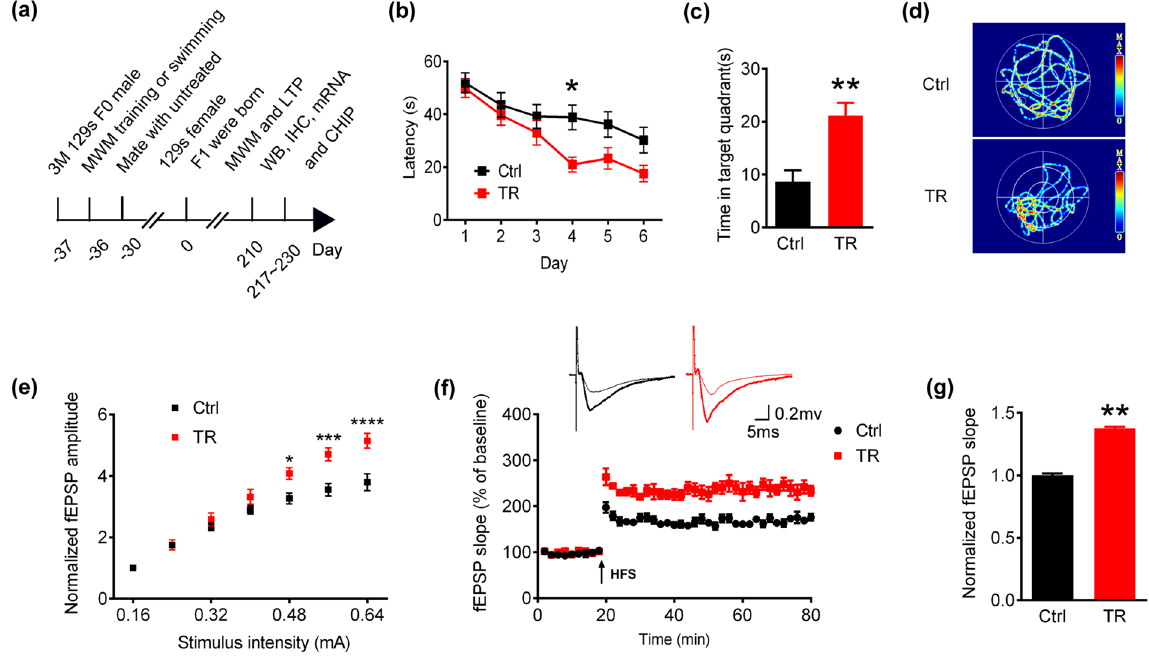
Figure 1. Paternal spatial training improves cognitive performance and synaptic transmission in 129s F1 offspring. ( a ) Spatial training paradigm and the experimental procedures. The birth of F1 offspring was defined as day zero. 37 days ago, F0 males were collected and engaged to Morris water maze (MWM) training or swimming (control). Those who behaved well were selected to mate with untreated females after MWM. The F1 offspring from different cages were bred under the same maintenance. When offspring grew up to 7-m old, they were conducted with MWM, Electrophysiological analysis (LTP), Western blotting (WB), Immunohistochemistry (IHC), mRNA extraction, and Chromatin immunoprecipitation (ChIP). ( b ) Escape latency to find the hidden platform in Morris water maze during 6 days training (two-way ANOVA row factor, F 5,229 = 10.72, p < 0.0001; Bonferroni post hoc tests, * p < 0.05, n = 8 per group). ( c ) Quantitative analysis of time spent in the target quadrants measured at day 8 after removed the platform. Bar graphs show mean ± SEM ( ** p < 0.01, two-tail t-test, n = 6~8 per group). ( d ) The swimming pathway in the maze recorded at day 8 after removed the platform. ( e ) The Input/Output curve of the fEPSP recorded at cornu ammonis 1 (CA1) pyramidal neurons, normalized by fEPSP amplitude induced by minimum stimulation intensity (two-way ANOVA row factor, F 6,70 = 137.4, p < 0.0001; Bonferroni post hoc tests, * p < 0.05, *** p < 0.001, **** p < 0.0001, 5 slices from 3 mice per group). ( f ) The slope of fEPSP after HFS, normalized by the fEPSP slope before HFS